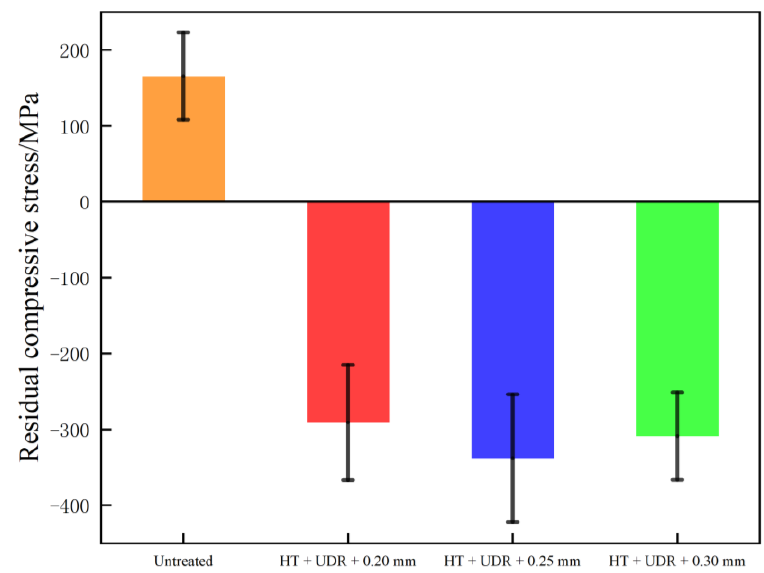
Figure 9. Residual stress of the coating under different preloading depths.